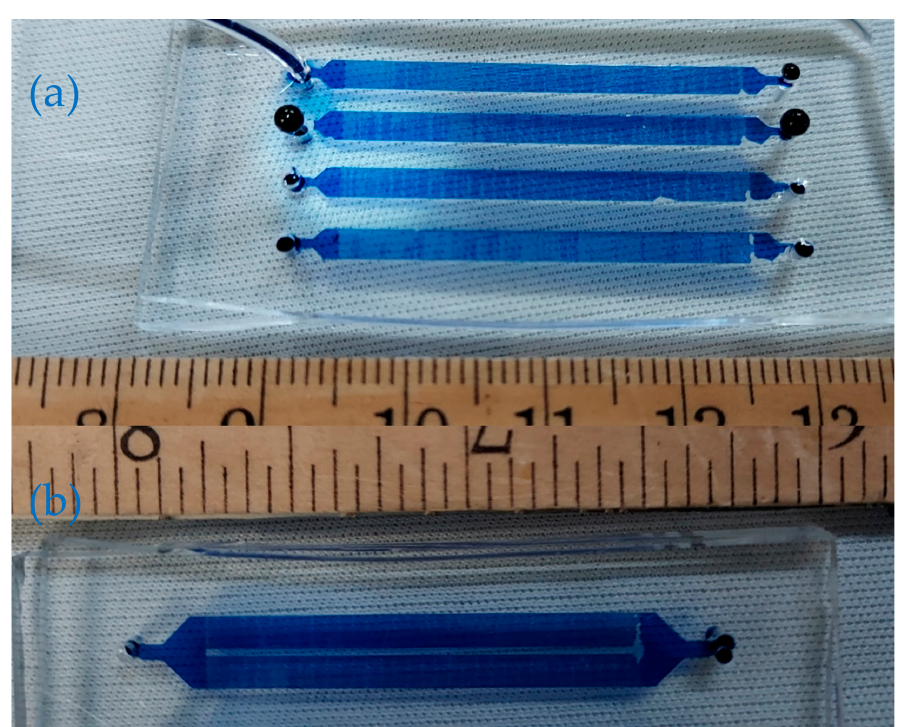
Figure 6. Digital pictures of the successful filling chips with a single channel ( a ) and ( b ) dual channels after alignment and bonding. Video S2 in the Supplementary Material shows the filling step. Table 1. Comparison of our alignment settings and other reports .